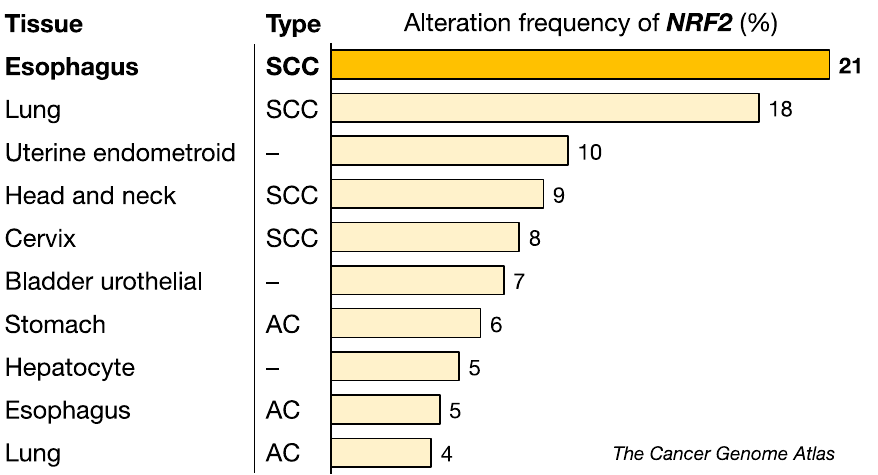
Figure 4. Alteration frequency of the NRF2 gene in various cancers. ESCC has the highest alteration frequency among the cancers examined. NRF2 mutations appear to be more common in SCC than in AC. SCC, squamous cell carcinoma, AC, adenocarcinoma. Data were obtained from the TCGA dataset.